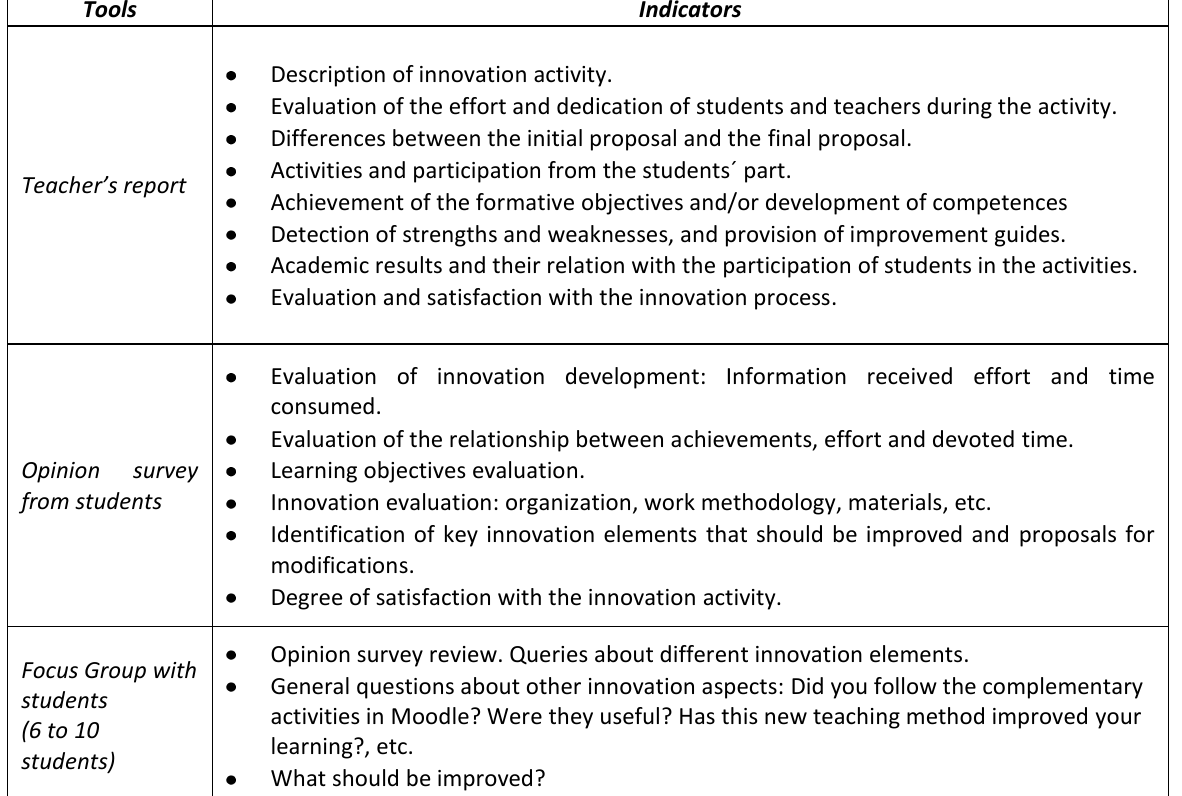
Table 2. Tools and indicators for measuring the quality of teaching innovations activity.